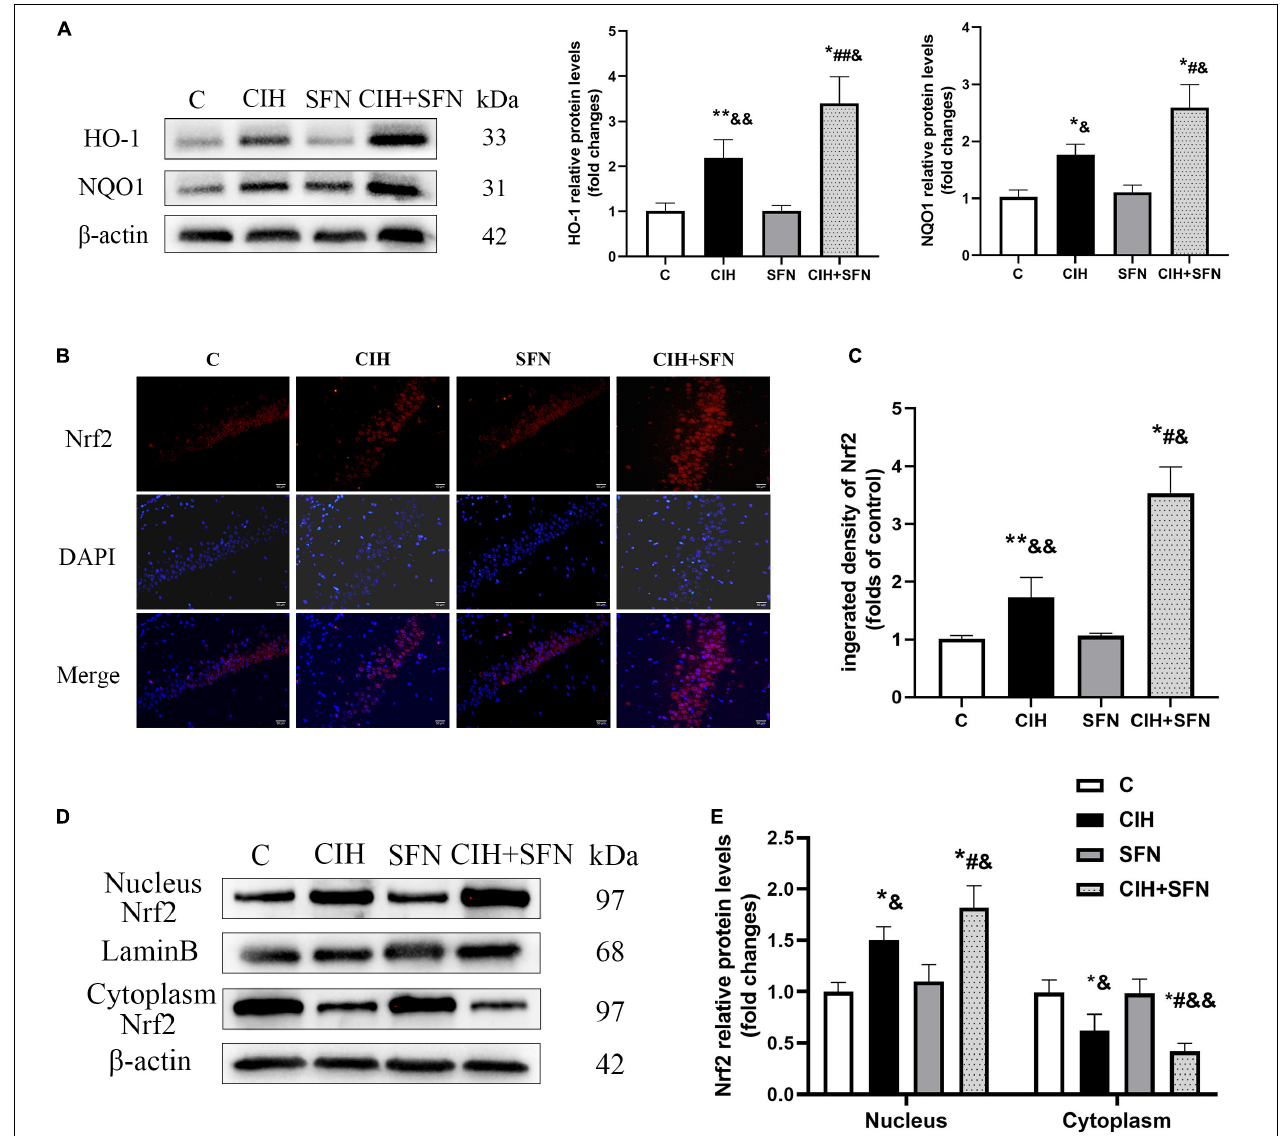
FIGURE 4 | SFN activates Nrf2-ARE by enhancing Nrf2 nuclear translocation after CIH. (A) Representative immunoblots and analysis of HO-1 and NQO1 in each group from the hippocampus. (B,C) Representative immunofluorescence images demonstrating nuclear translocation of Nrf2 in hippocampal CA1 region after CIH exposure with or without SFN pretreatment. Scale bar, 20 µ m. (D,E) Representative immunoblots and analysis of nucleus and cytoplasm Nrf2 in each group from the hippocampus. n = 5, * p ≤ 0.01 vs. C; ** p ≤ 0.05 vs. C; # p ≤ 0.01 vs. CIH; ## p ≤ 0.05 vs. CIH; & p ≤ 0.01 vs. SFN; && p ≤ 0.05 vs.